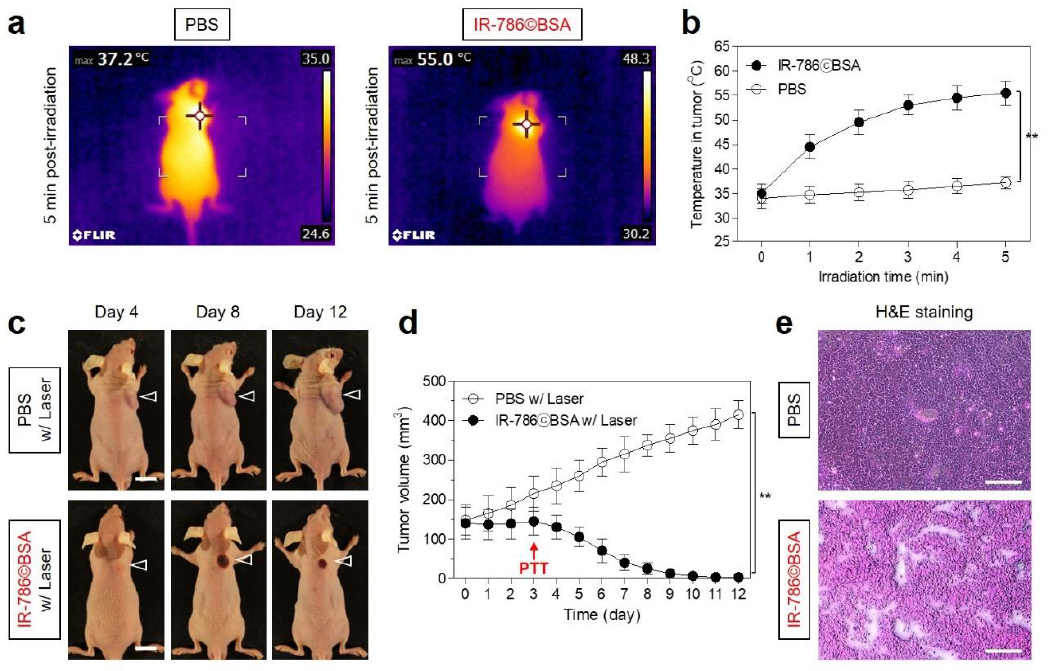
Figure 7. In vivo NIR phototherapeutic efficacy. ( a ) Whole-body thermal images of tumor-bearing mice 72 h after injection of PBS or IR-786©BSA upon exposure to 808 nm laser irradiation (1.1 W/cm 2 ) for 5 min. ( b ) Temperature changes at the tumor sites in each treatment group were monitored during the 5 min of 808 nm laser irradiation. ( c ) Representative photos of tumor size changes in HT-29 tumor-bearing mice for 12 days after different treatments. The tumor sites are indicated by arrowheads. Scale bars = 1 cm. Images are representative of 3 mice per treatment group. ( d ) Tumor growth rates of each treatment group were monitored for 12 days. ( e ) Tumor sections stained with H&E from each group after 24 h of diff erent treatments. Scale bars = 100 μm. Data are expressed as mean ± S.D. ( n = 3, ** p < 0.01).